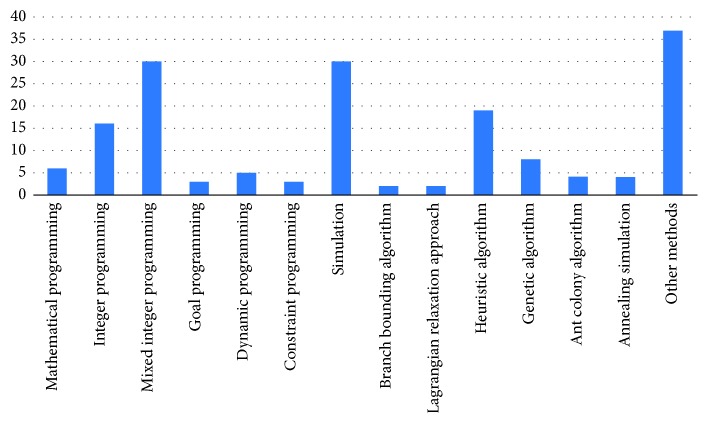
Solution techniques.